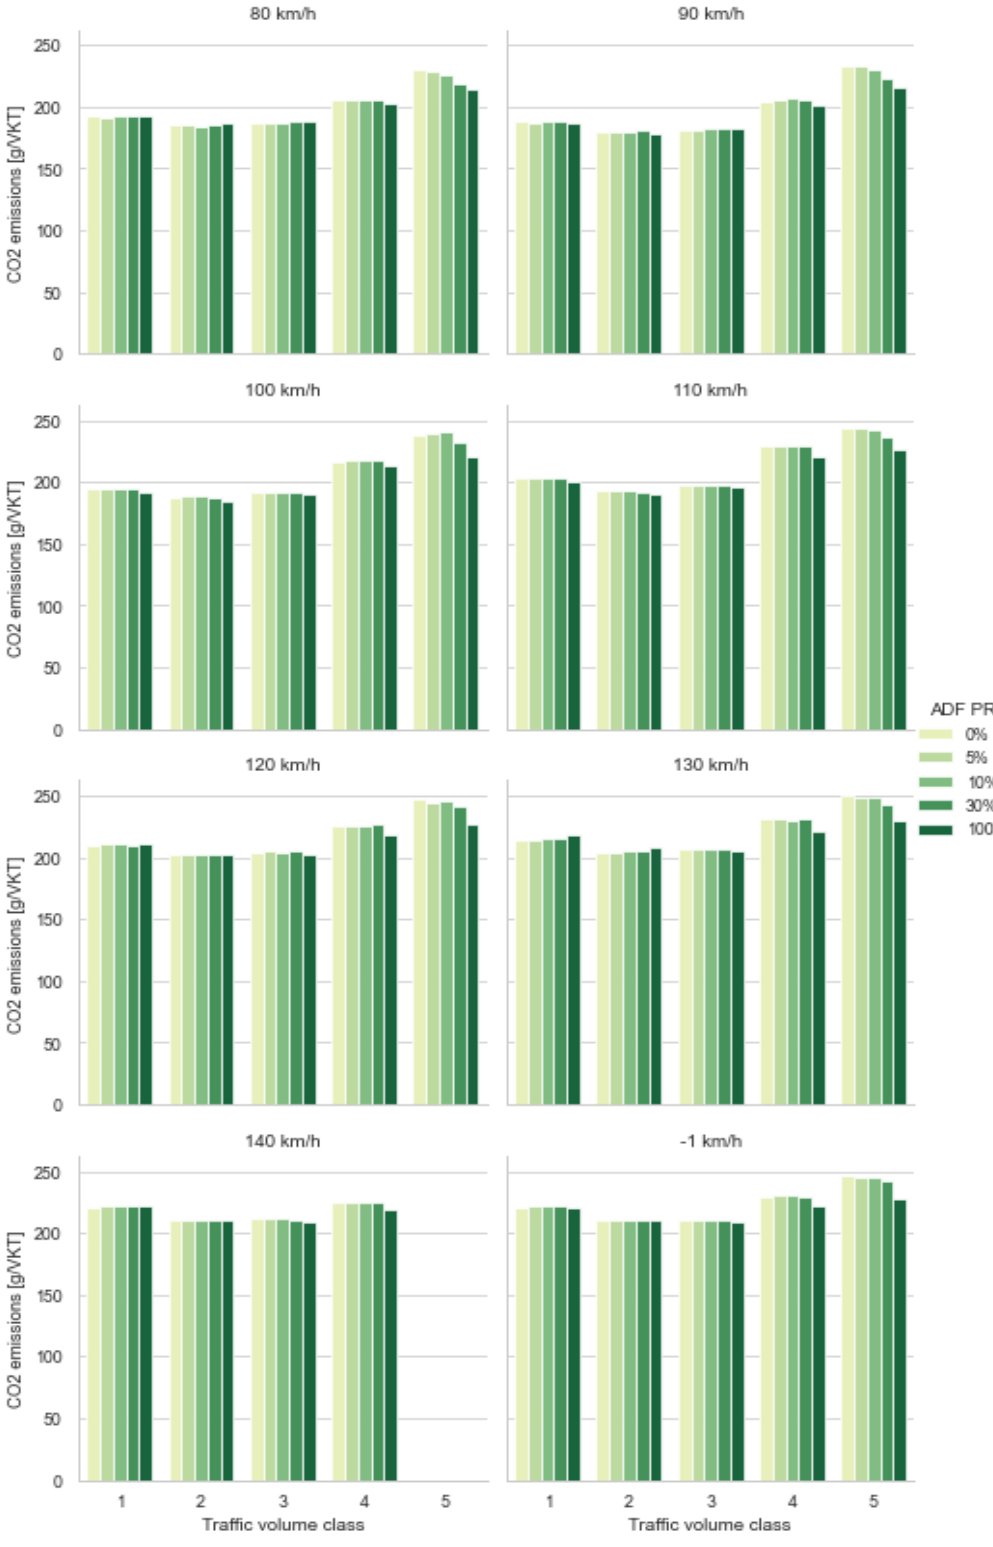
Figure 12. Average CO 2 emissions in grammes per VKT for speed limits 80 to 140 km/h and unlimited (-1 km/h) per traffic volume class and AV penetration rate on EU27+3 motorways. Volume class 1: up to 750 veh/h/lane; 2: 751–1250 veh/h/lane; 3: 1251–1750 veh/h/lane; 4: 1751–2250 veh/h/lane; 5: over 2250